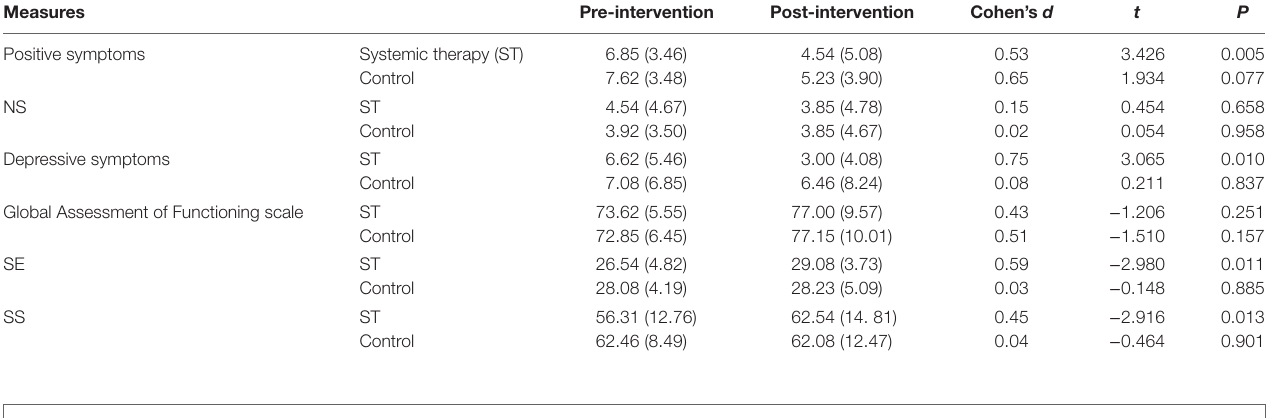
TaBle 3 | Comparison of changes between groups.